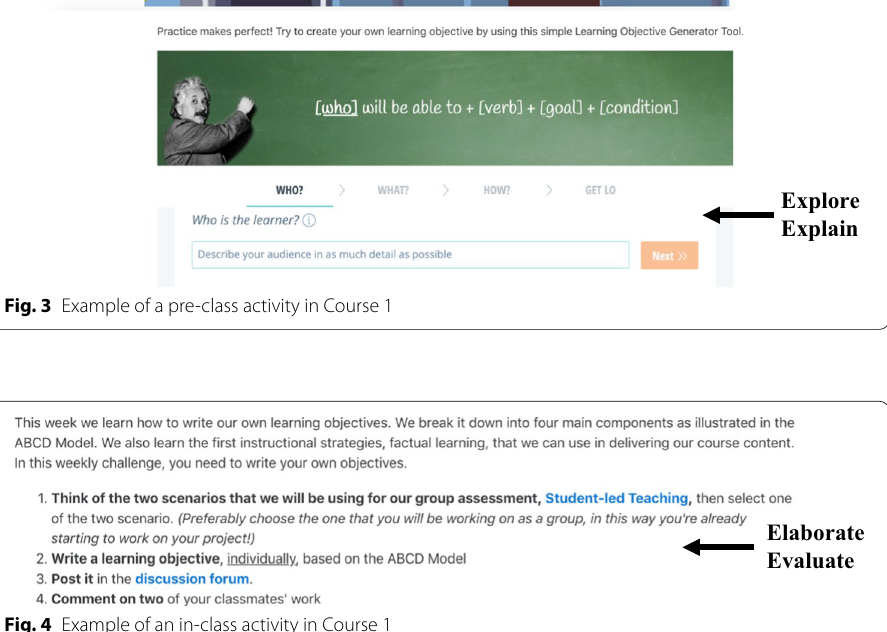
Fig. 4 Example of an in-class activity in Course